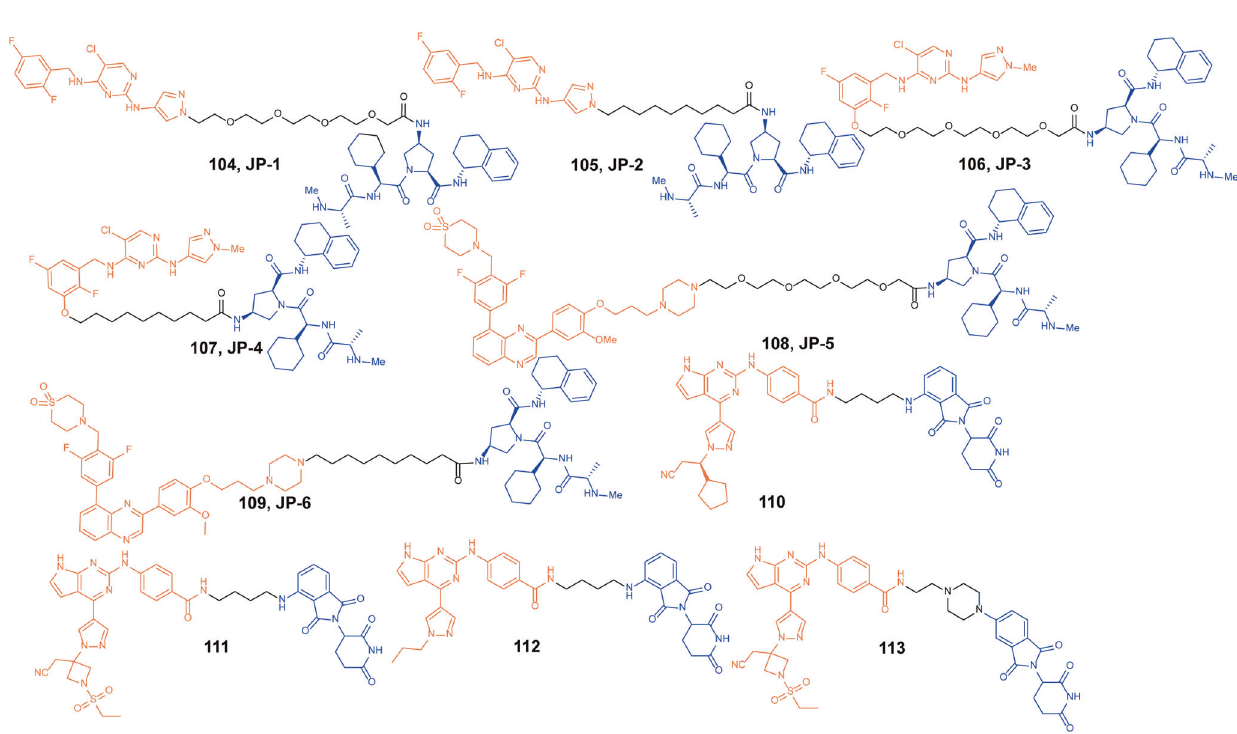
Fig. 25 The representative PROTACs targeting JAK